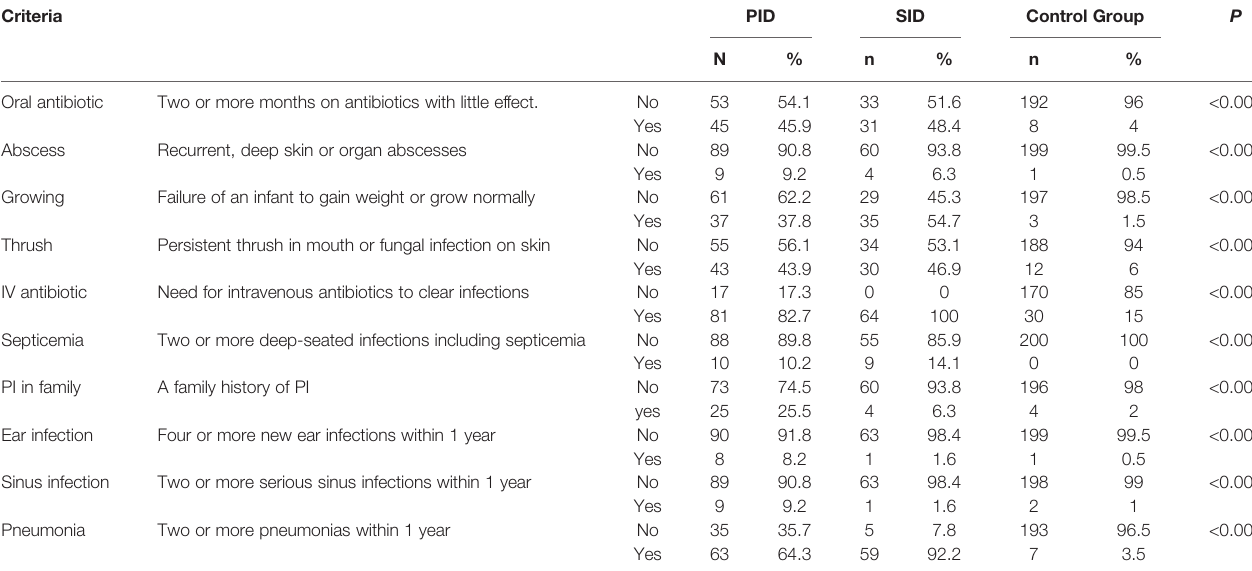
TABLE 2 | Distribution of the warning signs of the groups according to Jeffrey Modell Foundation. Criteria